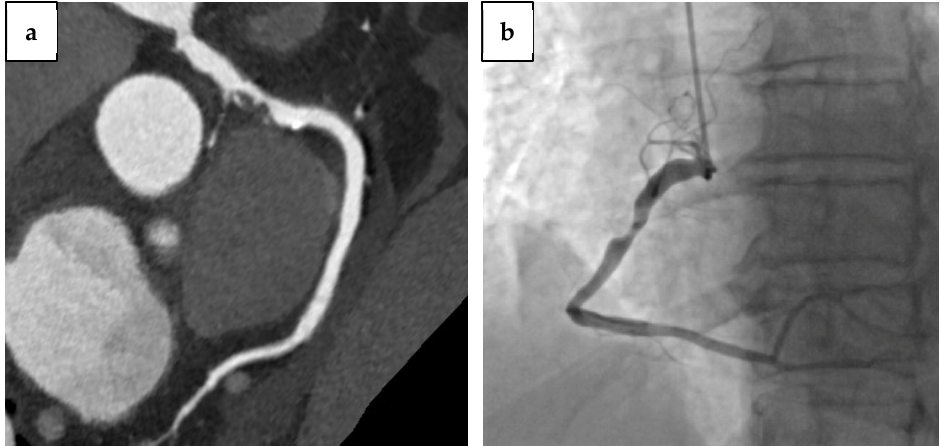
Figure 1. Right coronary artery unstable plaque: ( a ) Coronary computed tomography angiography (CCTA) assessment; ( b ) invasive coronary angiography (ICA) assessment.